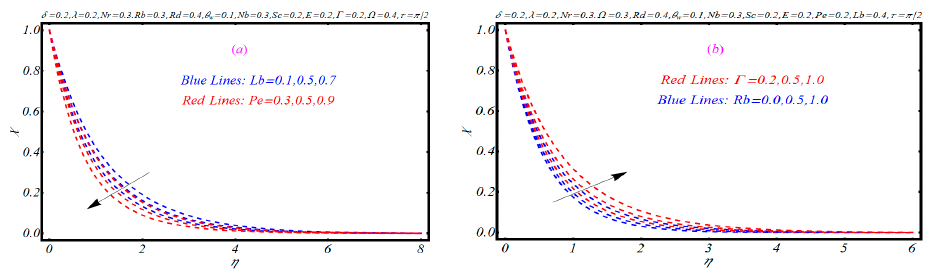
Figure 5. Variation in χ for ( a ) Lb and Pe , ( b ) Γ and Rb